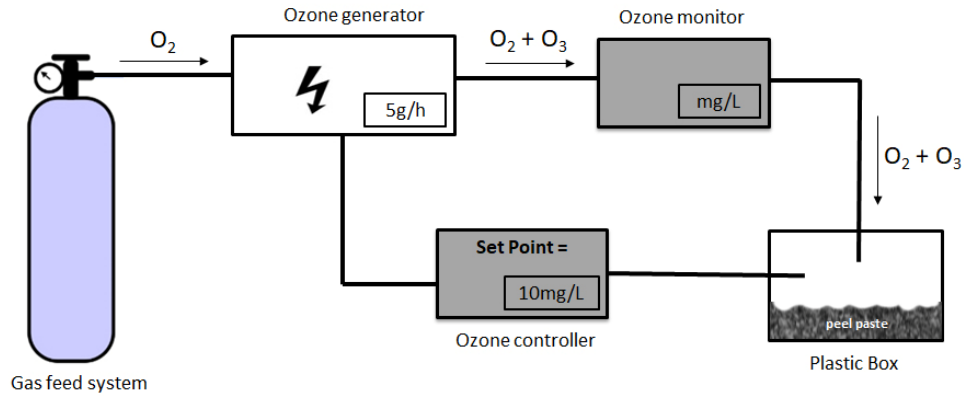
Figure 1. Experimental setup of the ozonation system used.